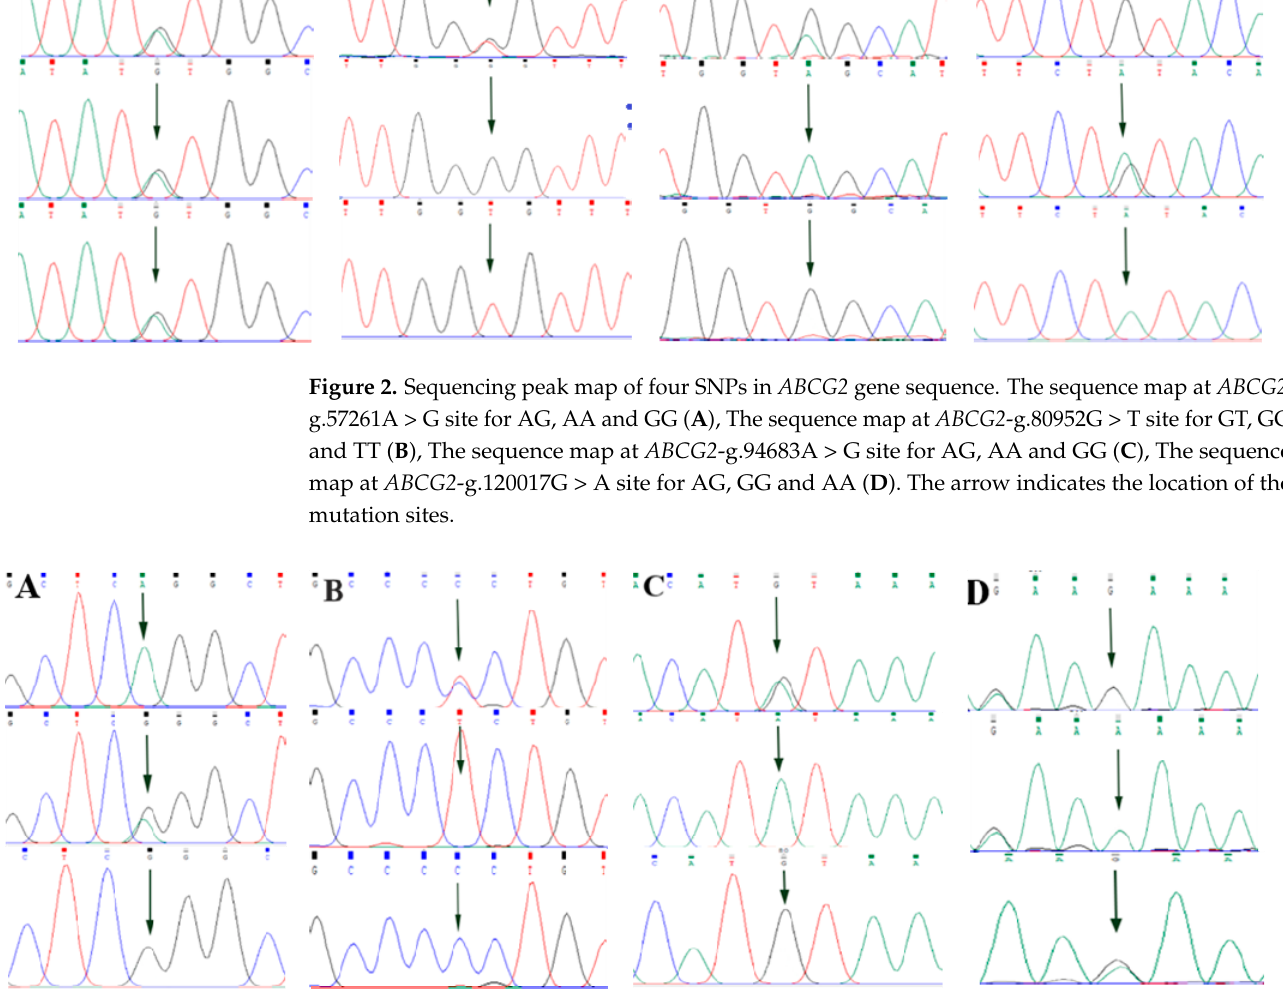
Figure 3. Sequencing peak map of four SNPs in CD44 gene sequence. The sequence map at CD44 -g.2263A > G site for AG, AA and GG ( A ), The sequence map at CD44 -g.2294G > C site for CG, GG and CC ( B ), The sequence map at CD44 -g.86895A > G site for AG, AA and GG ( C ), The sequence map at CD44 -g.86978G > A site for AG, AA and GG ( D ). The arrow indicates the location of the mutation sites.